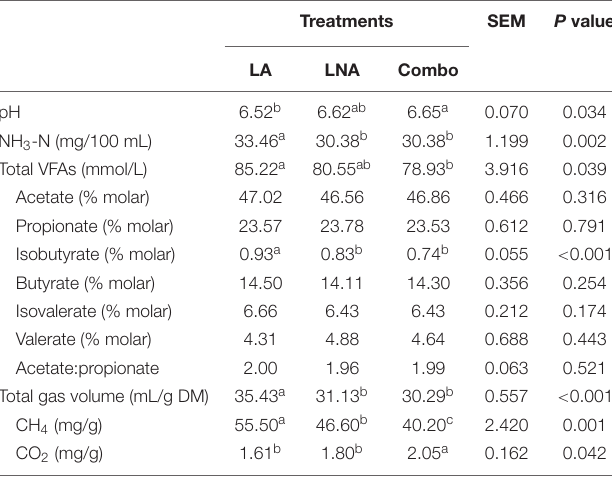
TABLE 3 | Effects of fatty acid supplementation on the fermentation indices and greenhouse gas emissions of rumen buffer after 8 h of incubation. Treatments SEM P